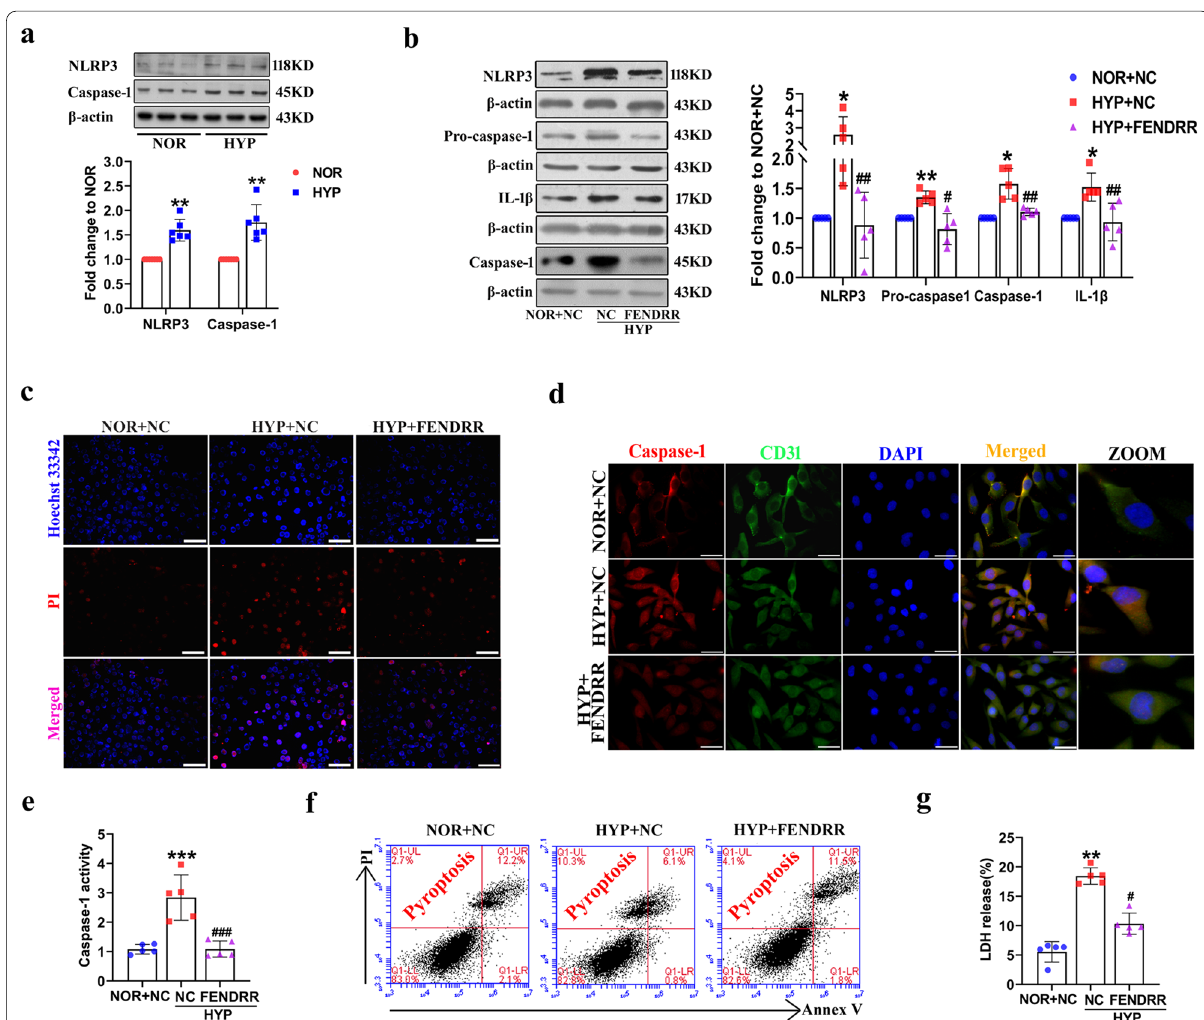
Fig. 2 Overexpression FENDRR inhibits hypoxia-induced HPAECs pyroptosis. a The protein levels of NLRP3 and Caspase-1 were elevated after hypoxia exposure 24 h (n 6). b Overexpression FENDRR reversed the increased protein levels of Caspase-1, NLRP3, Pro-caspase-1 and IL-1β = induced by hypoxia in HPAECs (n 5). c The positive PI (red) cells were detected in hypoxic HPAECs transfected with FENDRR overexpression = plasmid. Scale bar 50 μm. d Fluorescence staining of Caspase-1 in HPAECs transfected with FENDRR overexpression plasmid. HPAECs were stained = for Caspase-1 (red) and CD31 (green), and DAPI (blue) was used for nuclear staining. Scale bar 50 μm. e The activity of caspase-1 was examined = using caspase-1 activity assay kit (n 5). f The Flow cytometry assay was used to detect the population of positive-PI cells. HPAECs were treated = with annexin V-FITC/propidium iodide (PI) double staining using quantitative fluorescence-activated cell sorting (FACS) analysis. g HPAECs were transfected with FENDRR overexpression plasmid under hypoxia and the LDH release was evaluated by LDH release kit (n 5). Each datapoint in the = figure represents a unique biological replicate. All values are presented as the mean SD. Statistical analysis was performed with one-way ANOVA ± or the Student’s t-test. NOR: normoxic; HYP: hypoxic; NC: negative control. *P < 0.05, **P < 0.01, ***P < 0.001 compared with NOR NC. # p < 0.05, + ## p < 0.01, ### p < 0.001 compared with HYP +